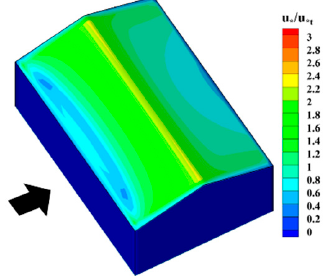
Figure 19. Normalized friction velocity u ∗ / u ∗ t